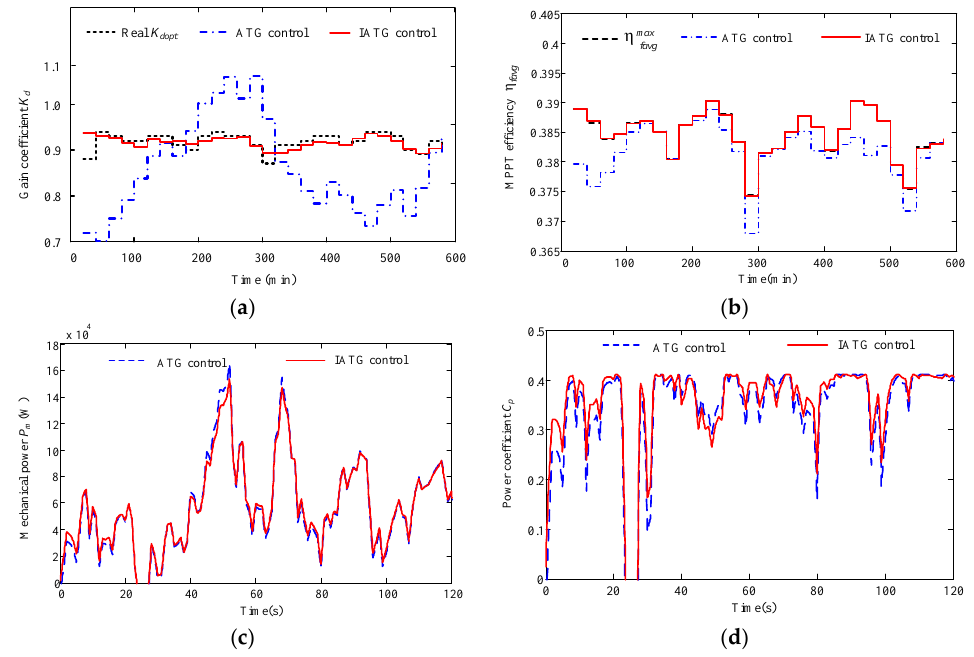
Figure 11. MPPT performances in searching the optimal gains under wind speed with T i of category A: ( a ) K d of ATG and IATG control; ( b ) MPPT efficiency η favg ; ( c ) mechanical power P m ; and ( d ) power coefficient C p .